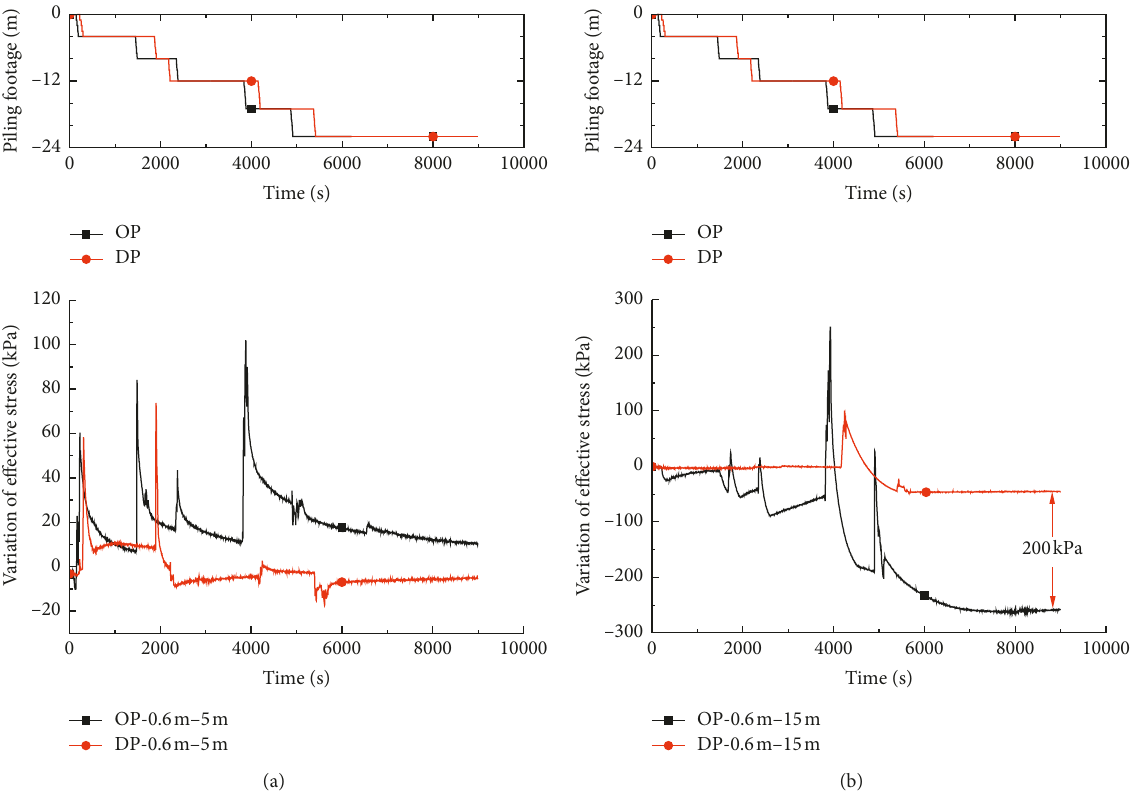
Figure 10: Time histories of the effective stress variation at 0.6m from the pile center. (a) At 5m depth. (b) At 15m depth.